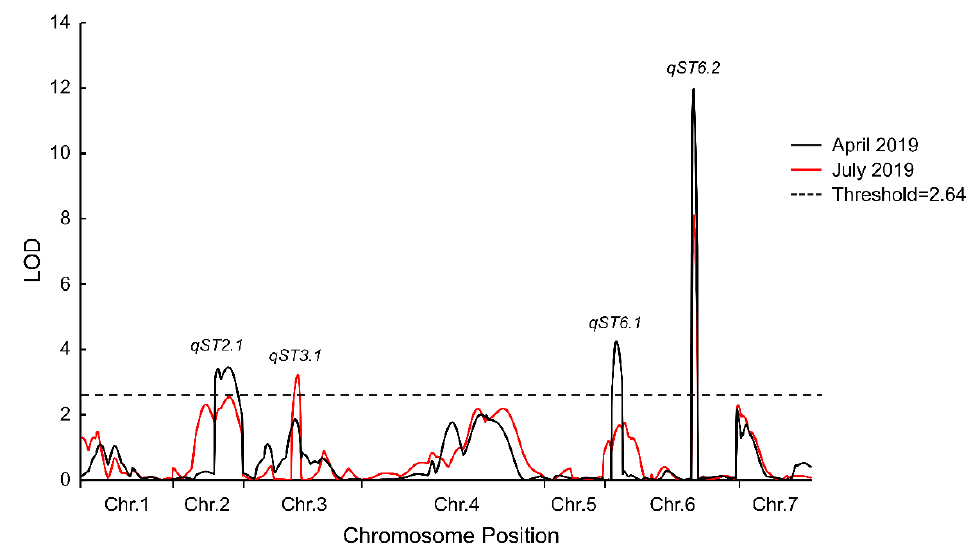
Figure 4. Identified quantitative trait loci (QTL) controlling salt tolerance in cucumber seedlings. The black line indicates the experiment performed in April 2019; the red line indicates the experiment performed in July 2019. qST6.2 on chromosome six was detected in both April 2019 and July 2019.